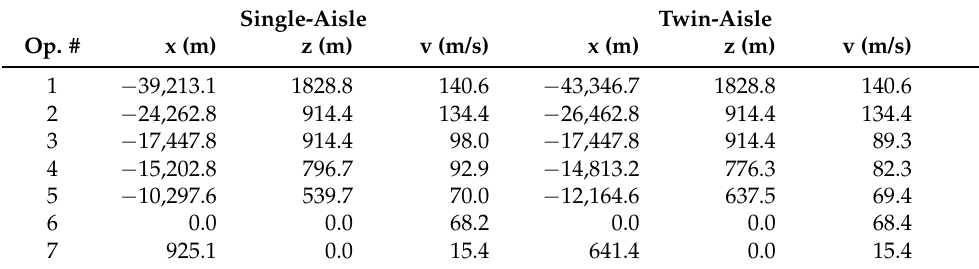
Table 3. Reference approach manoeuvre for the single- and twin-aisle aircraft: geometric and kinematic